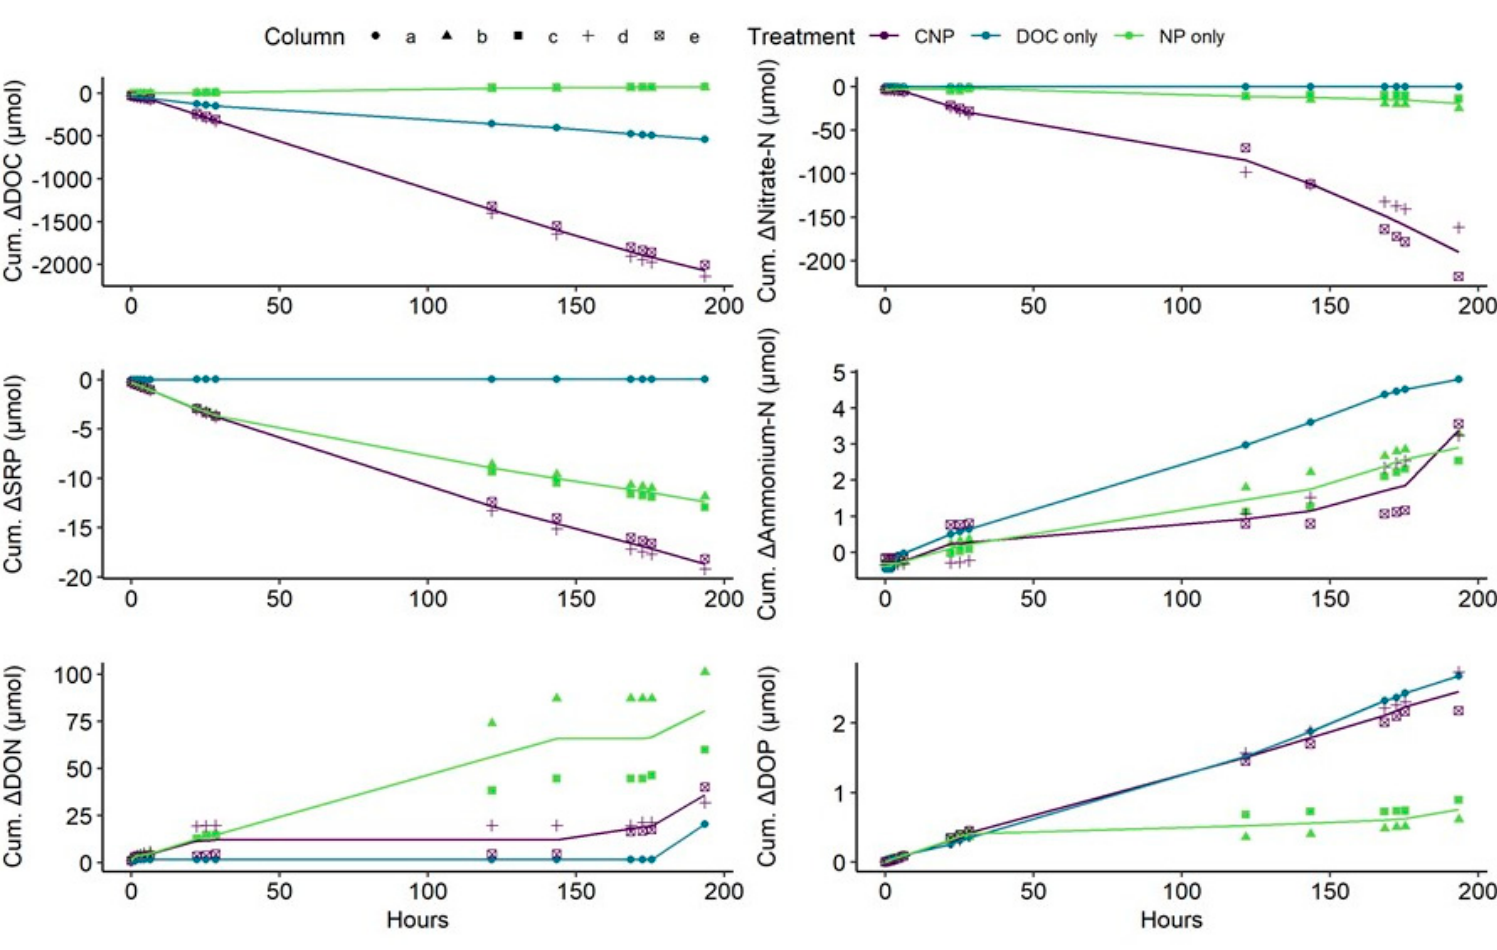
Figure 3. Cumulative net release and uptake mass (positive and negative values, respectively) of DOC, NO 3 -N, SRP, NH 4 -N, DON and DOP (total amounts in µmol) for the five columns (data points) and average lines for the three treatments (accounting for duplicated columns). Data show µmol cumulative change over ~200 h of leaching (~600 PV equivalents).